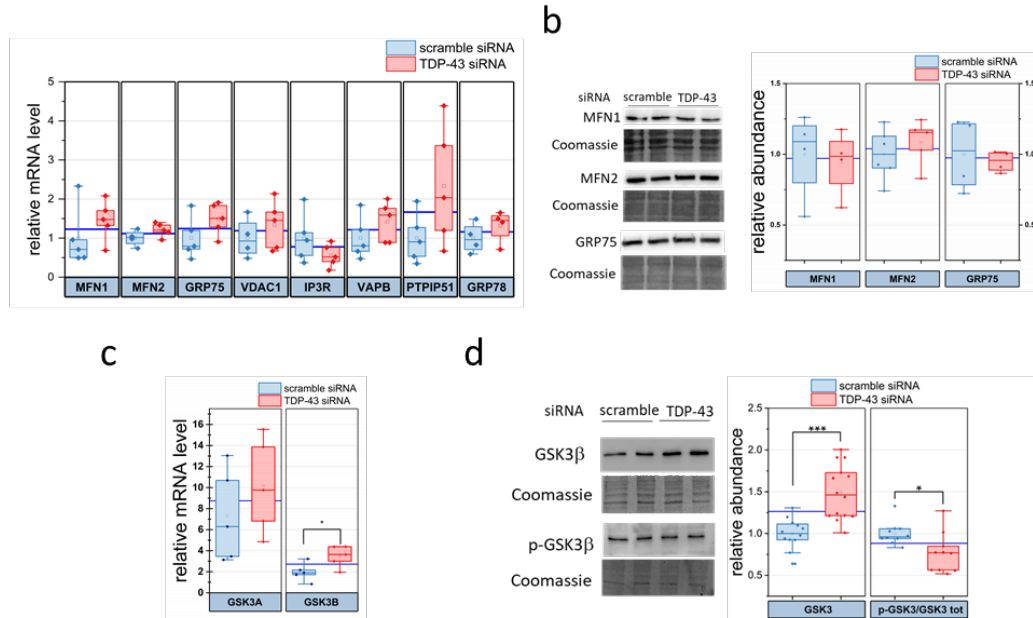
Figure 5. RT-PCR and WB analyses of proteins involved in ER–mitochondria tethering show increased expression and activation of glycogen synthase kinase-3 β (GSK3 β ) inTDP-43-silenced HeLa cells. ( a ) RT-PCR analysis of targeted genes in TDP-43-silenced and control (scramble) HeLa cells. Due to high differences in relative mRNA levels between different genes, for the sake of clarity, in this diagram, data of each gene were further normalised to the corresponding control value. n = 4, p -value > 0.06. ( b ) HeLa cells lysates (with or without TDP-43 silencing) were analysed by WB for the expression of MFN1, MFN2 and GRP75. Representative WB images for the proteins of interest and the corresponding Coomassie blue-stained membrane are shown in the left panel. The right panel reports the densitometric analysis for the screened proteins. n = 4, p -value > 0.1. ( c ) RT-PCR analysis of GSK3A and GSK3B mRNA levels in TDP-43-silenced and control (scramble) HeLa cells. * p -value < 0.05, Mann–Whitney U test. ( d ) TDP-43-silenced and control (scramble) HeLa cells lysates were analysed by WB using antibodies against total GSK3 β and phospho-Ser9 GSK3 β (p-GSK3 β ). The left panel shows representative WB images, while the plots on the right show the abundance of total GSK3 β and of the p-GSK3 β /GSK3 β ratio (see Materials and Methods). n = 14 for both scrambled and TDP-43 siRNA samples, for total GSK3 β ; n = 10 for p-GSK3β/GSK3β; * p -value <0.05, *** p -value < 0.01, Mann–Whitney U test for all statistics.